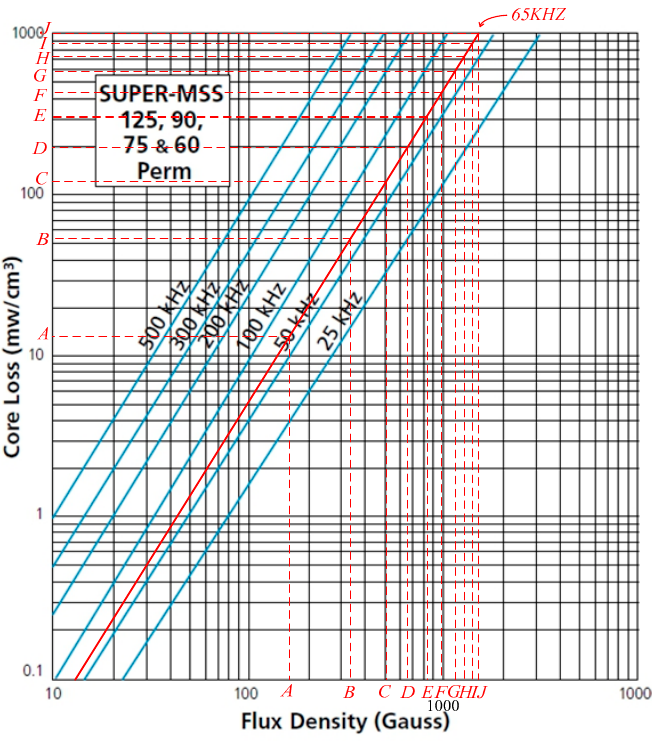
Figure 14. Core loss curves of inductors L 1 ~ L 4 manufactured by Arnold Magnetics LTD. Table 6. Power loss analysis for the proposed boost converter under input voltage of AC 110 V.